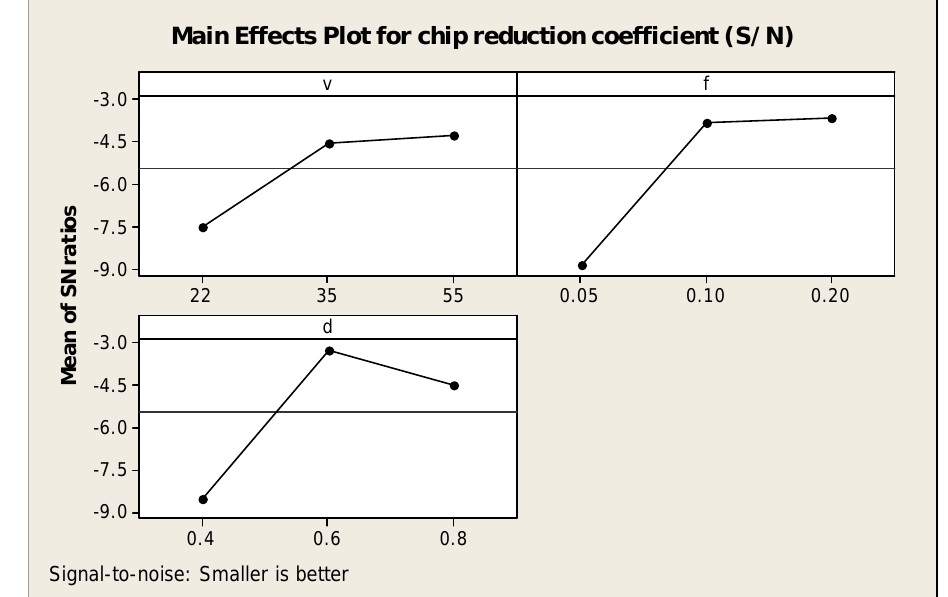
Fig. 3. Main effect plot for chip reduction coefficient Results of the verification experiment for chip reduction coefficient Initial cutting